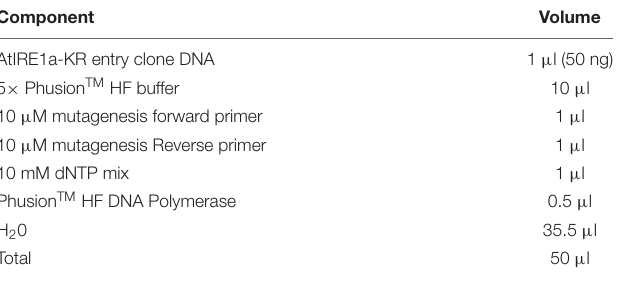
TABLE 2 | AtIRE1-KR site-directed mutagenesis PCR setup.